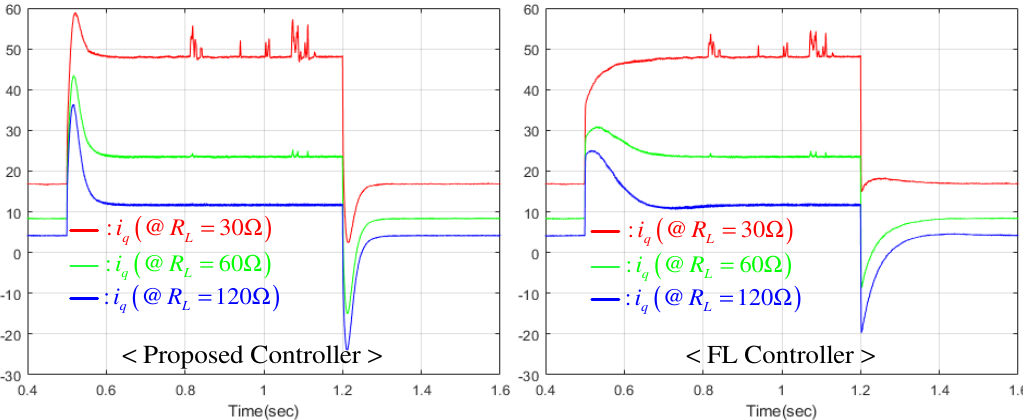
Figure 4. q -axis current response comparison result under DC-link voltage tracking control